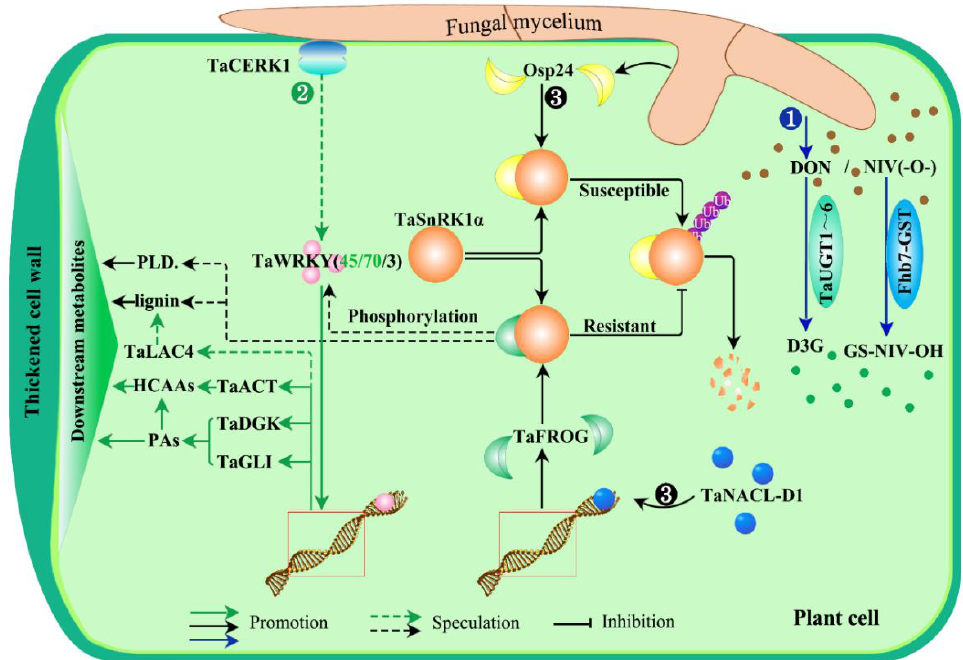
Figure 3. FHB-resistant signaling pathways in fungus–plant interactions. There are three resistant pathways: first, the detoxification pathway, in which the members of (UDP)-glucose transferase TaUGT1~6 can enhance plant tolerance to FHB by converting the fungal mycotoxin DON to the less toxic DON-3-O-glucoside, D3G ( ❶ ). In addition, another gene, Fhb7, encoding a glutathione S-transferase (GST), from a distant variety of wheat, Elytrigia elongata , confers broad resistance and tolerance to Fusarium species by detoxifying trichothecenes, such as NIV, through conjugating GSH to the epoxy group of NIV. Second are CERK1-mediated metabolic pathways to thicken the plant walls. It is well known that the first layer of innate immunity in plants is initiated by the surface- localized pattern recognition receptors (PRRs), in which the leading role is played by chitin elicitor receptor kinase 1 (CERK1), which mainly participates in chitin-induced immunity [107]. Meanwhile, chitin is a typical component of the fungal cell wall and can trigger the plant innate immune response by activating PAMPs (pathogen-associated molecular patterns). Here, a transcription factor, HvWRKY23, can be induced by HvCERK1 with some unclear methods upon infection with Fg . HvWRKY23 subsequently regulates downstream genes, such as HvPAL2 , HvCHS1 , HvHCT , HvLAC15 , and HvUDPGT , to biosynthesize HCAAs, flavonoid glycosides, lignin, and so on, which reinforces the cell walls to contain the spread of Fg in plant cells. Similarly, TaWRKY70 was also identified as having a potential role against Fg in the early stages of defense through physically interacing with and activating the downstream genes TaACT , TaDGK , and TaGLI , among